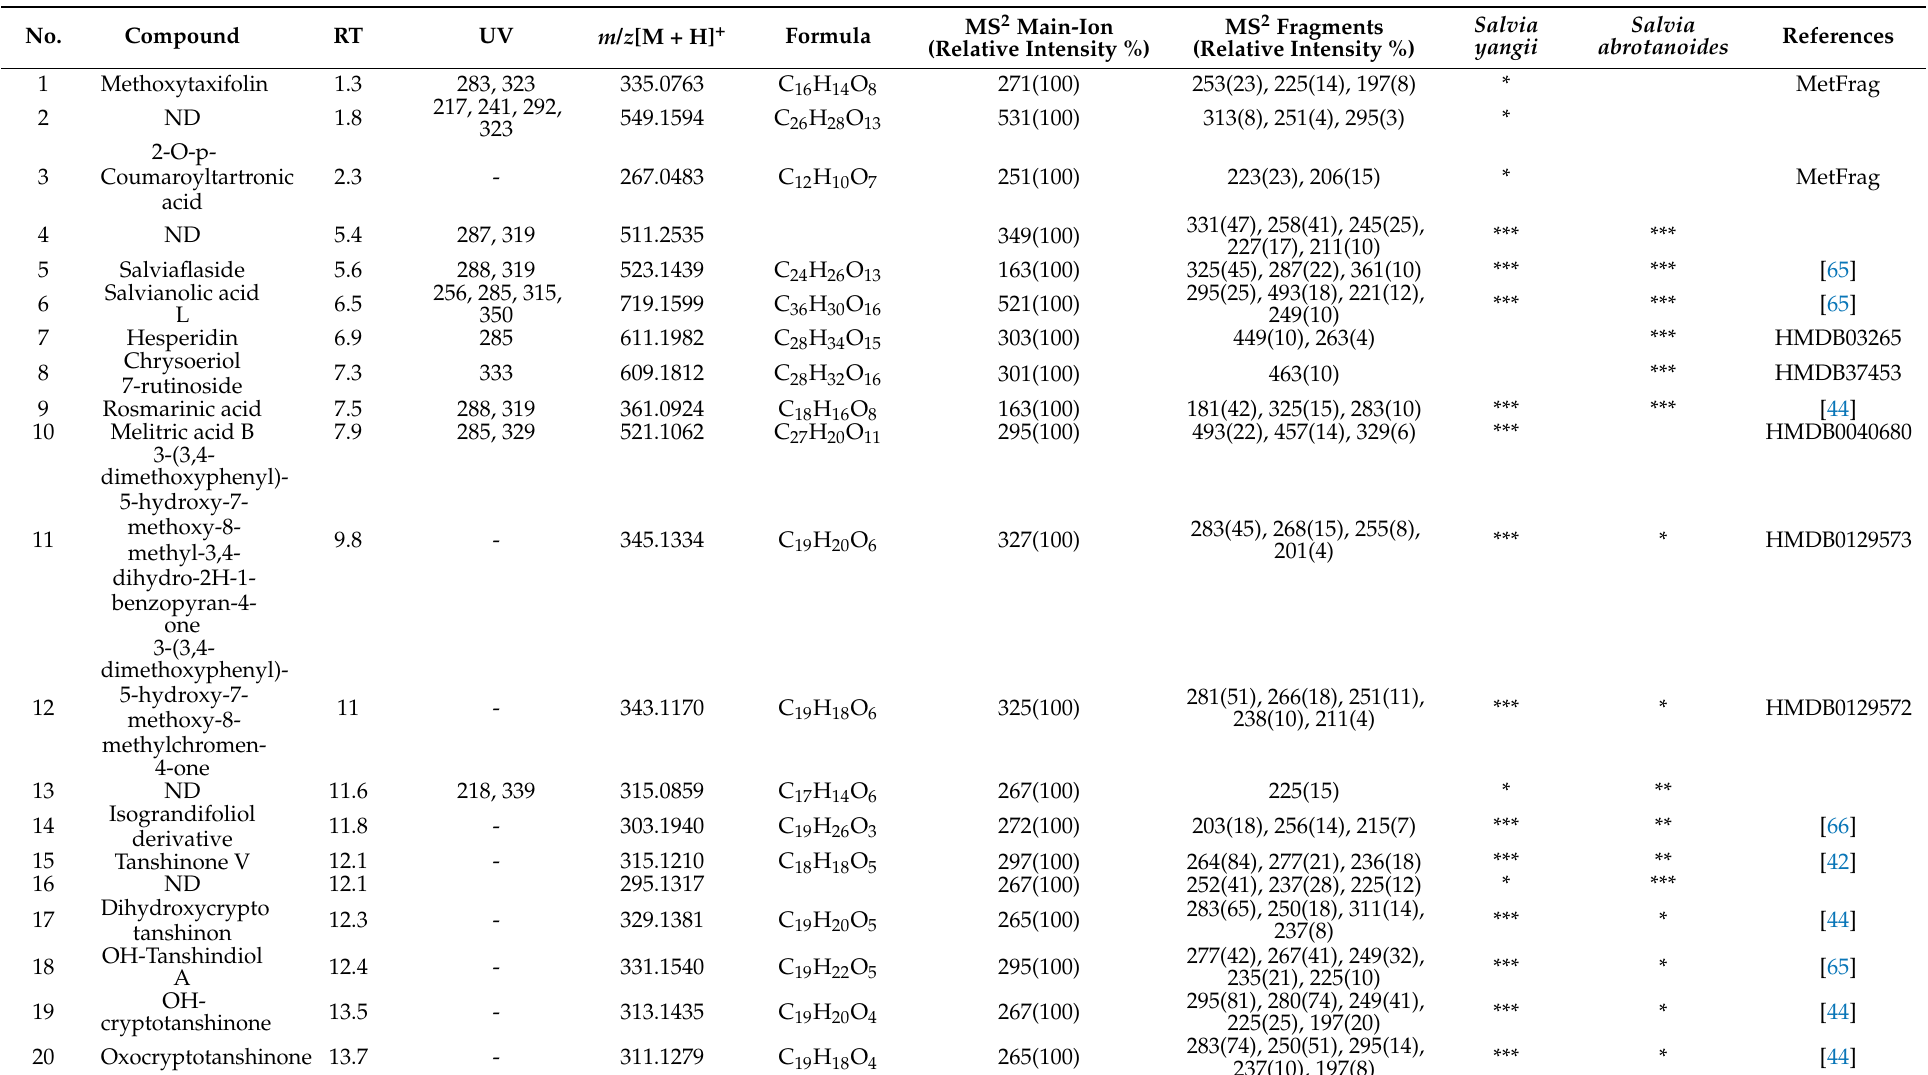
Table 3. Characterization of identified compounds in roots of S. yangii and S. abrotanoides , UHPLC–QTOF-MS in positive ion